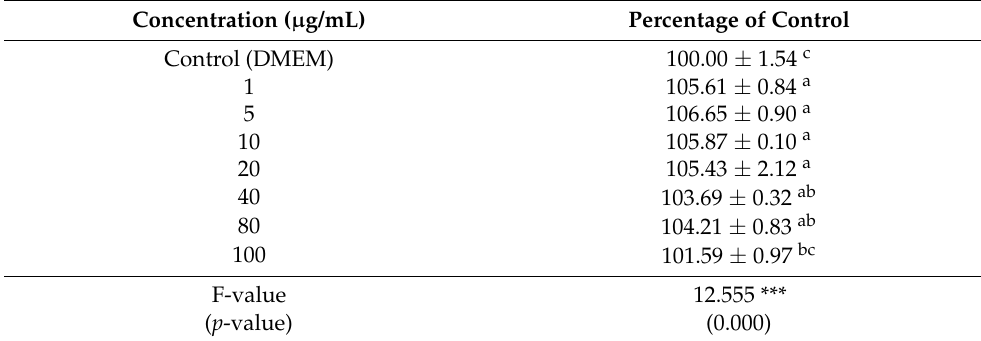
Table 4. HT22 cell viability in the hippocampus for validation of cognitive enhancement by roasted Sacha inchi.